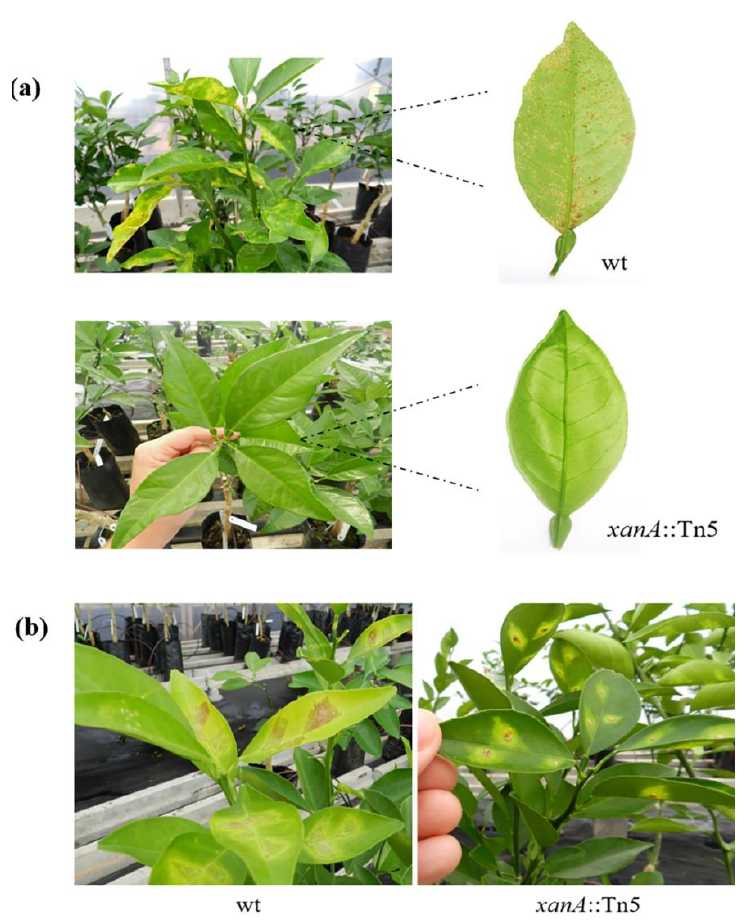
Figure 2. Pathogenicity assays. ( a ) Symptoms of sweet orange leave inoculated by spraying with wt and xanA ::Tn5 mutant strains. ( b ) Symptoms of sweet orange leave infiltrated with wt and xanA ::Tn5 mutant strains. Symptoms were analyzed for 30 days post-inoculation and pictures of leaves are representative of six independent replicates. wt, wild-type; xanA ::Tn5, EZ-Tn5 insertion mutant.